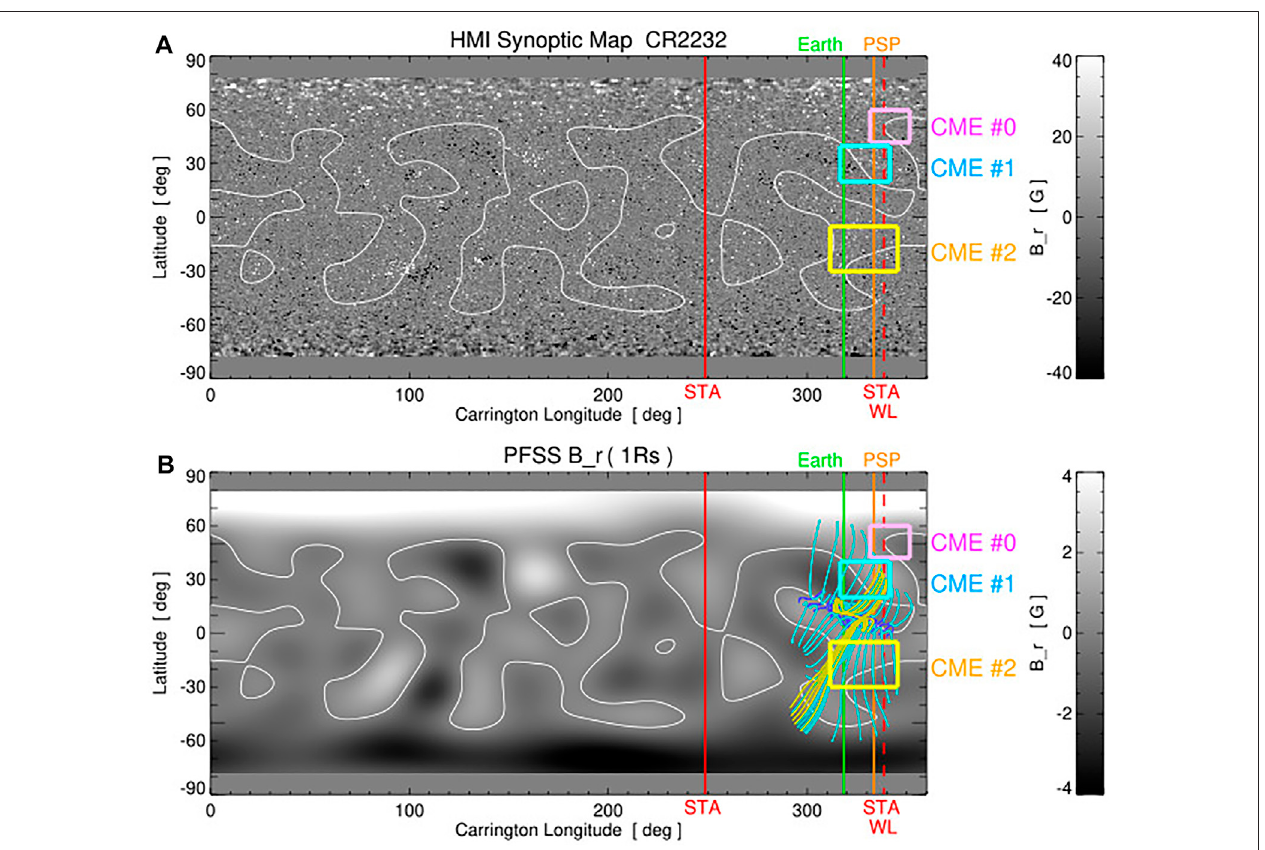
FIGURE 1 | (A) Synoptic magnetogram of photospheric B r from SDO/HMI. The blue, green, and red vertical lines denote the Carrington longitude of STEREO-A, SOHO/Earth,andPSPon21June2020,respectively. (B) SynopticmagnetogramofthePFSS B r showingthelarge-scale fl uxdistributionswithrepresentativemagnetic fi eld lines of the multipolar fl ux system on STA ’ s west limb (WL; red dashed vertical line). In both panels the average magnetic PILs are shown as the white contours and the three CME source regions are